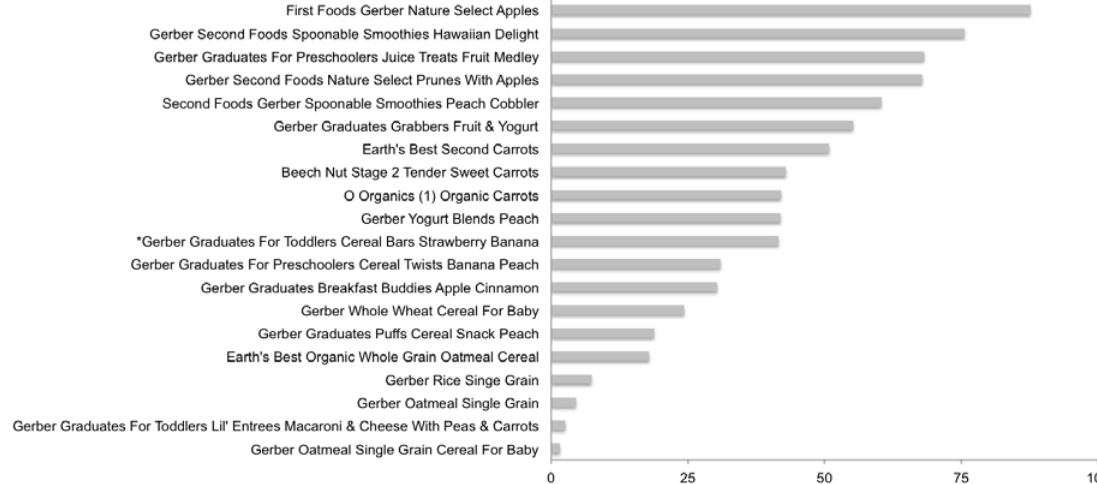
Figure 2. Percent of total calories from sugar: Baby Food. Values were derived from the following equation: % Total Calories from sugar = [(Total Sugar Actual per serving × 4)/Total Calories per serving] × 100.